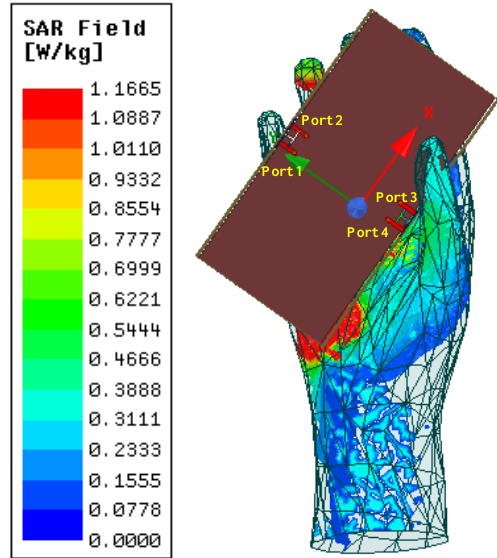
Figure 10. Simulated SAR field when Ant. 1 is excited at 3.5 GHz.